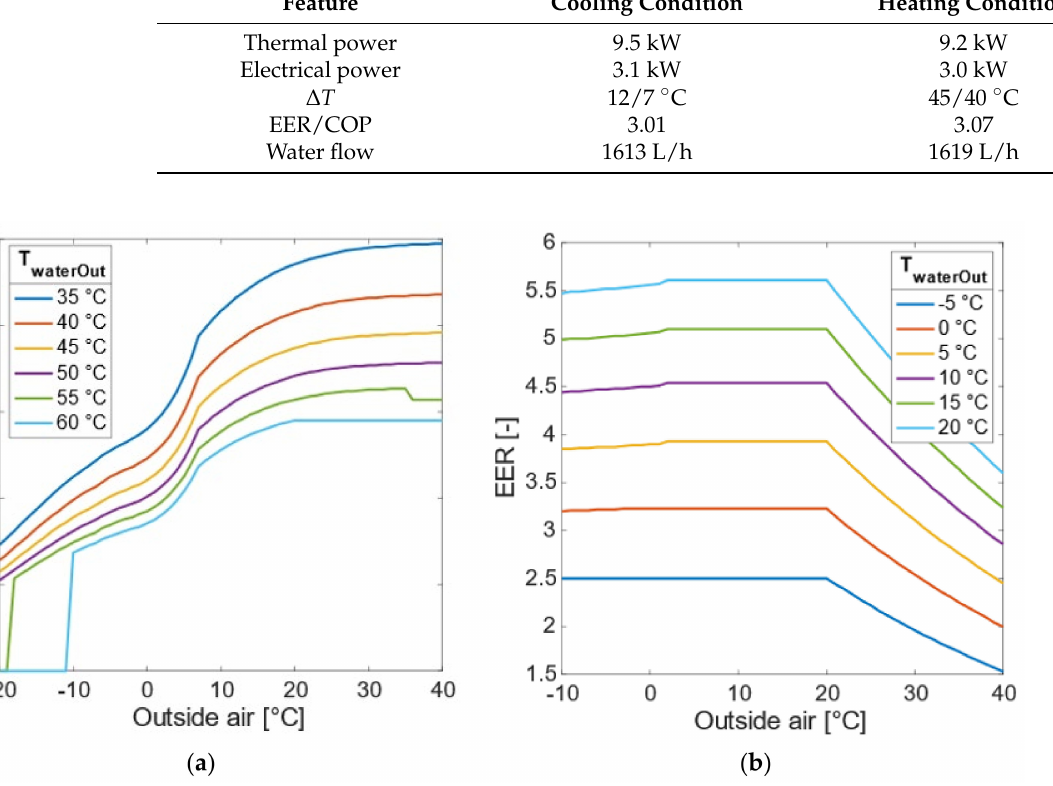
Figure 2. Air-Source Heat Pump (ASHP) performance map in heating ( a ) and cooling ( b )